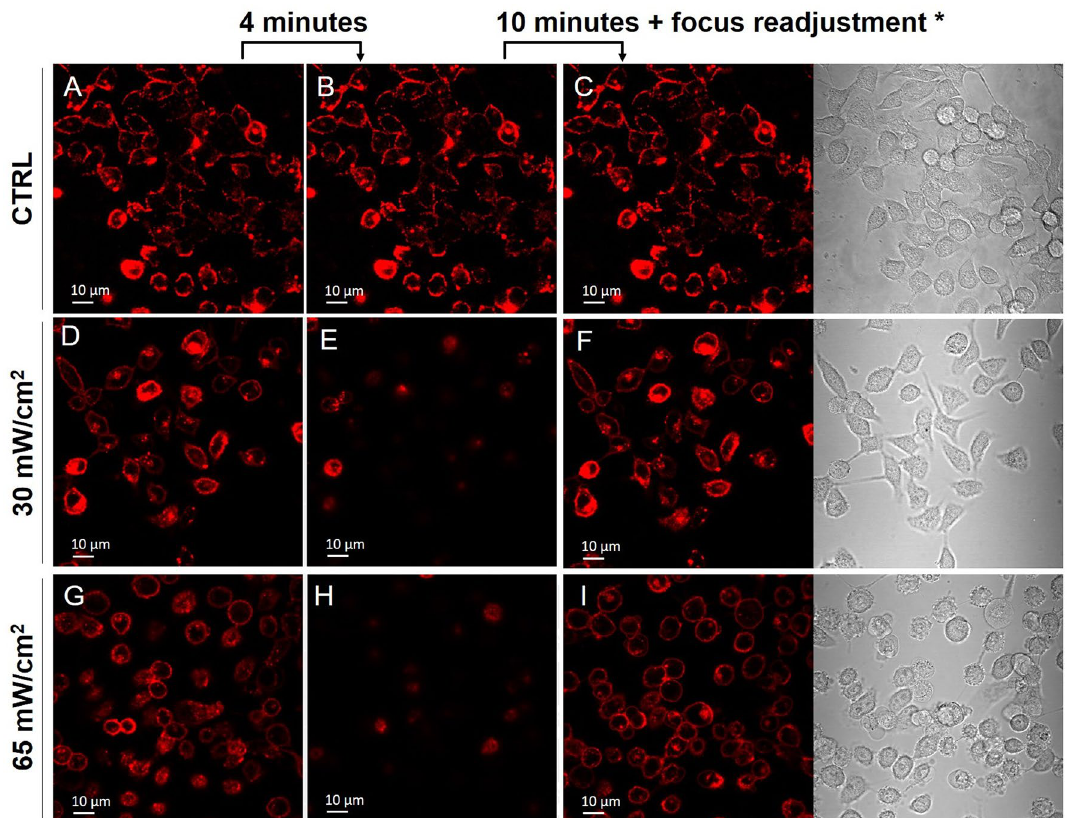
Figure 8. CLSM analysis of the morphology and positioning of HaCaT cells treated for 1 h with 1 MHz US using different acoustic intensities. For each I spta value, we acquired at 10 min time-lapse immediately after the US treatment. The first frame of each acquisition is reported in the first column ( A , D , G ), and the corresponding frames acquired in the same region after 4 min of time-lapse, in the same focus plane of the first image, are reported in the second column ( B , E , H ). The frames reported in the last column were acquired in the same regions of the previous columns, at the end of the time-lapse and after readjusting the focus of ~ 13 μm towards the bottom of the Petri dish to match the new position of cells ( C , F , I ); the corresponding transmission microscopy images are also reported in the last column. Each time-lapse acquisition is representative of at least three different experiments. *For the control sample, no focus readjustment was